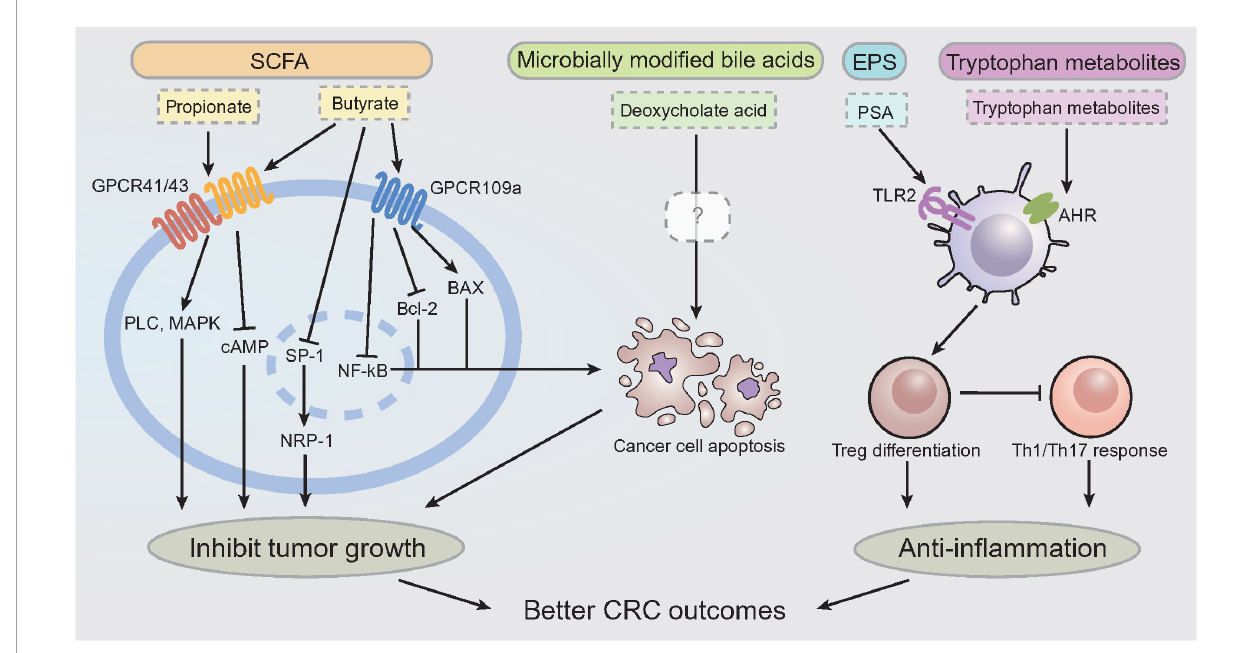
FIGURE4 Molecular mechanism of postbiotics on colorectal cancer prevention and treatment. Working mechanisms of postbiotics against CRC. It has been shown that propionate and butyrate can bind to GPCR41/43 to promote the activation of PLC, MAPK, and signals intracellularly to inhibit tumor cell growth. Butyrate also binds to GPCR109a, which inhibits downstream intracellular signals including SP-1, NRP-1, to inhibit tumor cell growth, and also promote apoptosis via BAX and inhibition of Bcl-2, NF-kB activity. Deoxycholate acid, a type of microbially modified bile acids, can promote cancer cell apoptosis through unidentified mechanism. PSA interacts with TLR2 to promote the activation of DCs, which lead to the upregulation of T regulatory cells in GI environment. Tryptophan metabolites interact with AHR to exert the anti-inflammatory activity as well. GPCR, G-protein couple receptor; PLC, phospholipase C; MAPK, mitogen-activated protein kinase; cAMP, cyclic AMP; SP-1, Specific protein 1; NRP-1, Neuropilin-1; PSA, polysaccharide; TLR, toll like receptor; DC, dendritic cell; AHR, aryl hydrocarbon receptor; CRC, colorectal